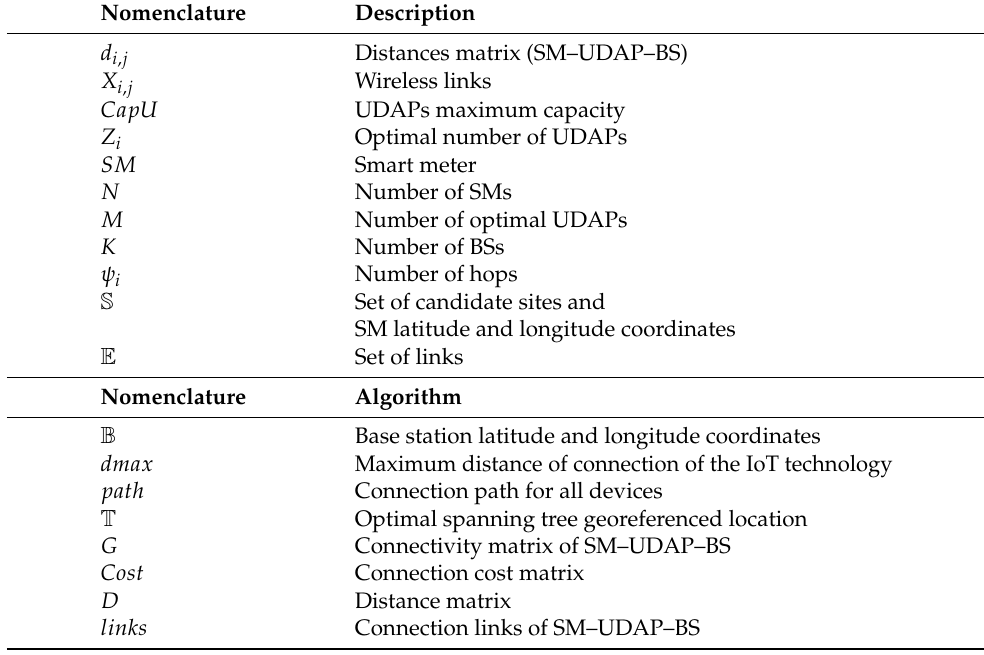
Table 3. General notation for model and algorithms.